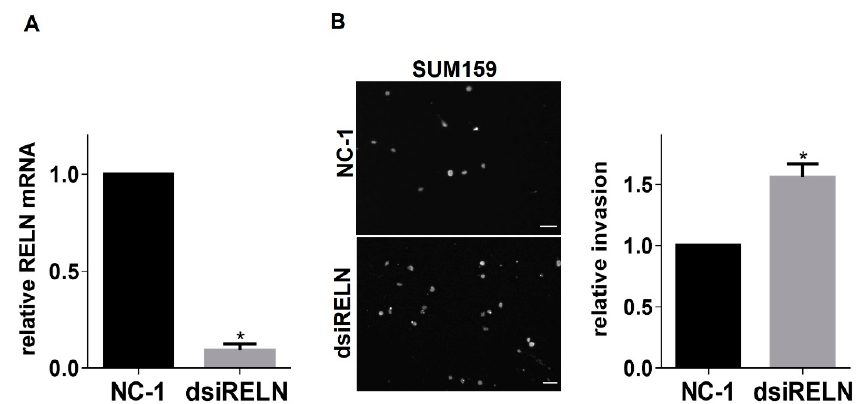
Figure 5. Suppression of RELN using dicer-substrate siRNA increases invasion of SUM159 cells. control dicer siRNA (NC-1) or dicer siRNA that targets RELN (dsiRELN 13.2). ( B ) Invasive potential of SUM159 cells transfected with NC-1 or dsiRELN 13.2 was compared using Matrigel invasion assays. Images show representative fields of DAPI-stained cells that had invaded to the undersides of transwell filters; scale bar, 100 μ M. Graph shows relative cell invasion. Data are average +/ − SEM, n = 3; * p ≤ 0.05, unpaired t -test.